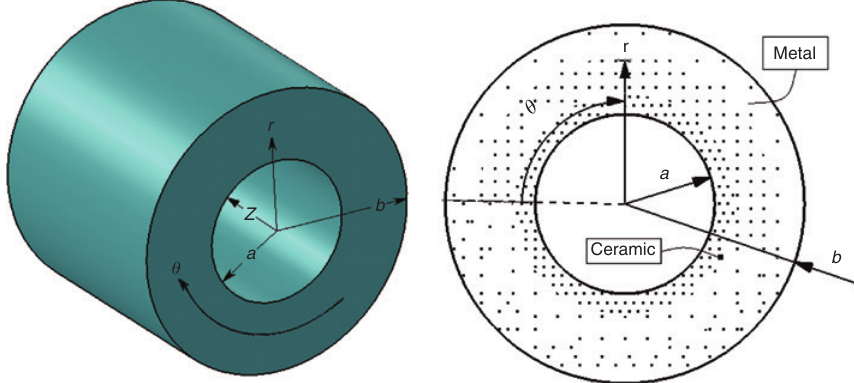
Figure 1: Configuration of the thick-walled FG